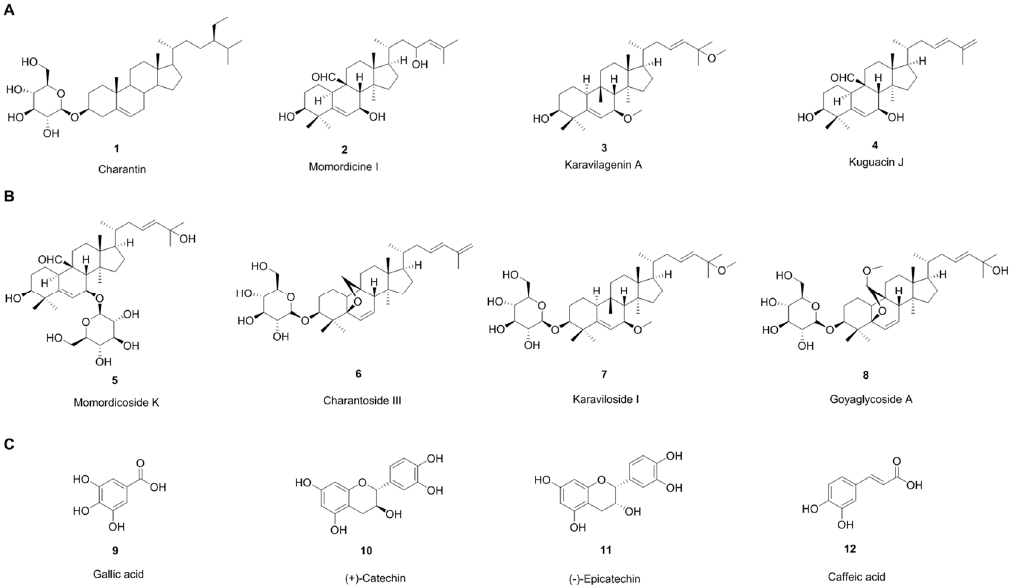
Figure 1. Chemical structure of some of the major components of bitter melon. ( A ): cucurbitane-type triterpenoids, ( B ): cucurbitane-type triterpene glycosides, and ( C ): phenolic compounds.